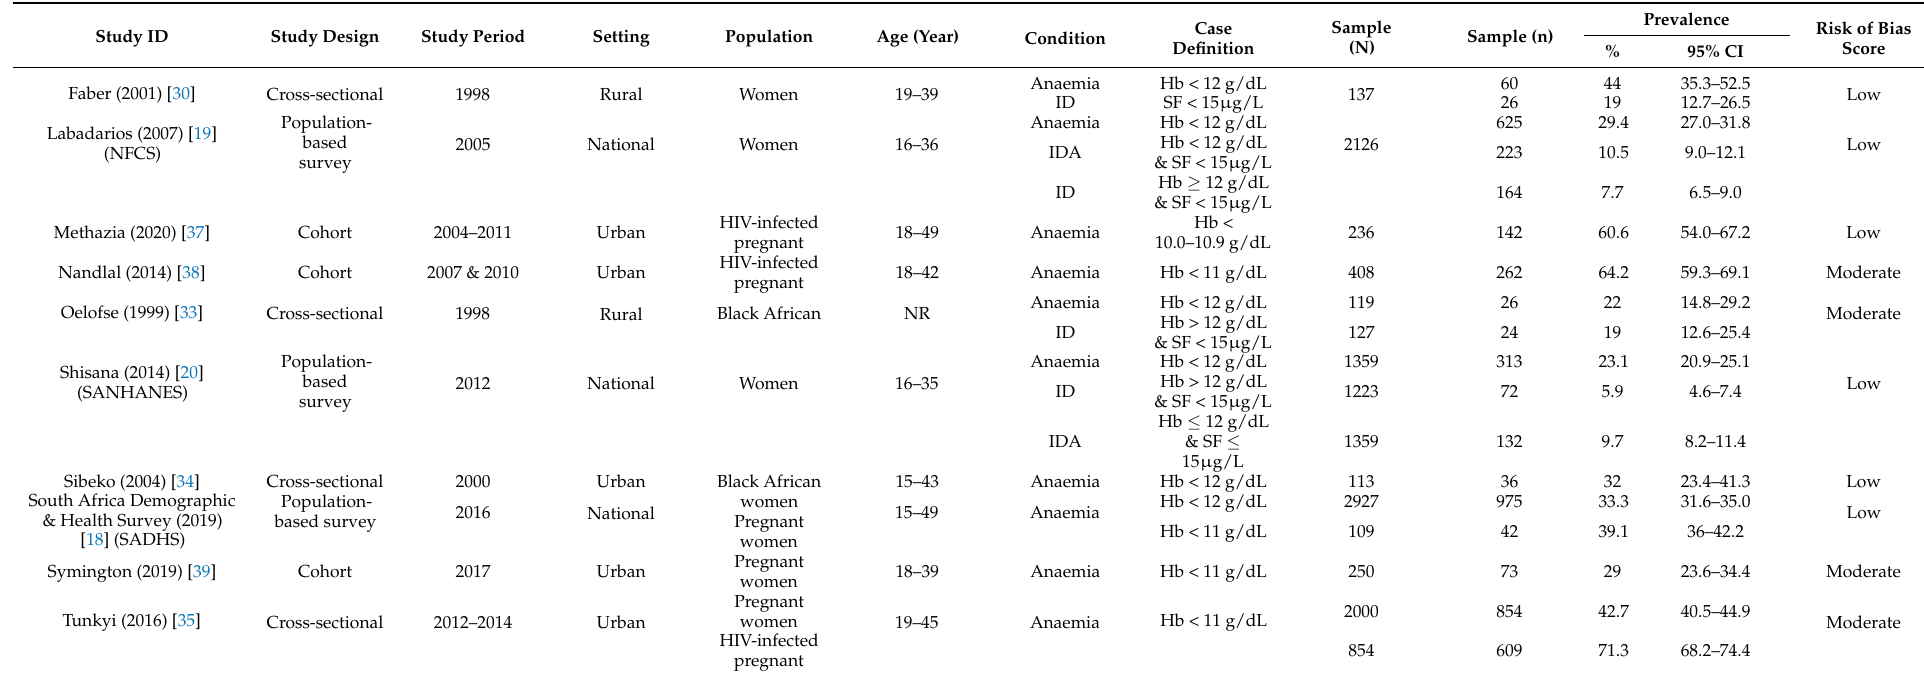
Table 1. Characteristics of included studies on anaemia, ID, and IDA in WRA (15–49 years) in South Africa,